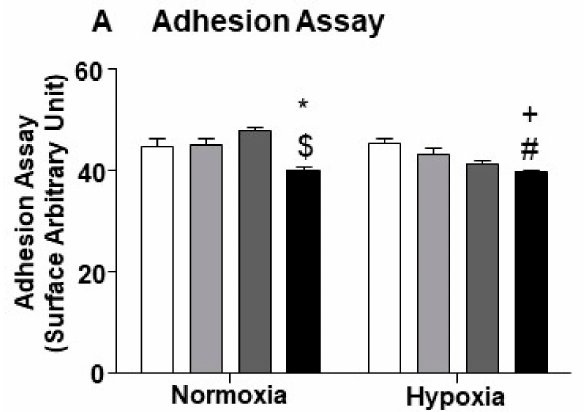
Figure 9. Reduced miR24 in ECs a ff ects the adhesion between ECs and pericyte. miR-24-3 under standard (5% O 2 ) or hypoxic culture conditions. Groups are pre-miR-24-3p transfected ECs miR-24-3p (black column); scramble control (dark grey column); vehicle control of transfection (light grey); and untreated cells (white column). Adhesion assay was performed using five wells per treatment and repeated two times. Values are means ± SEM. * p < 0.05 vs. untreated cells in normoxia; + p < 0.05 vs. untreated Cells in hypoxia; $ p < 0.05 vs. scramble in normoxia; # p < 0,05 vs. scramble control in